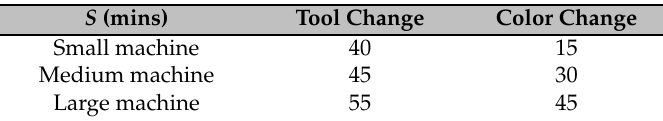
Table 4. Experimental setup time values.